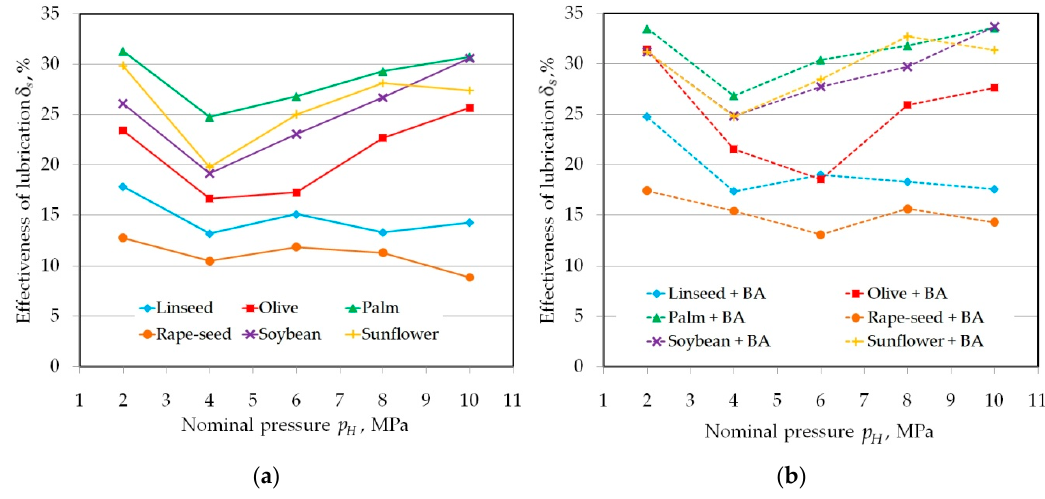
Figure 6. The effectiveness of lubrication on the value of the COF using ( a ) pure vegetable oils and ( b ) vegetable oils with added BA in tests carried out in the range of nominal pressure between 2 and 10 MPa.